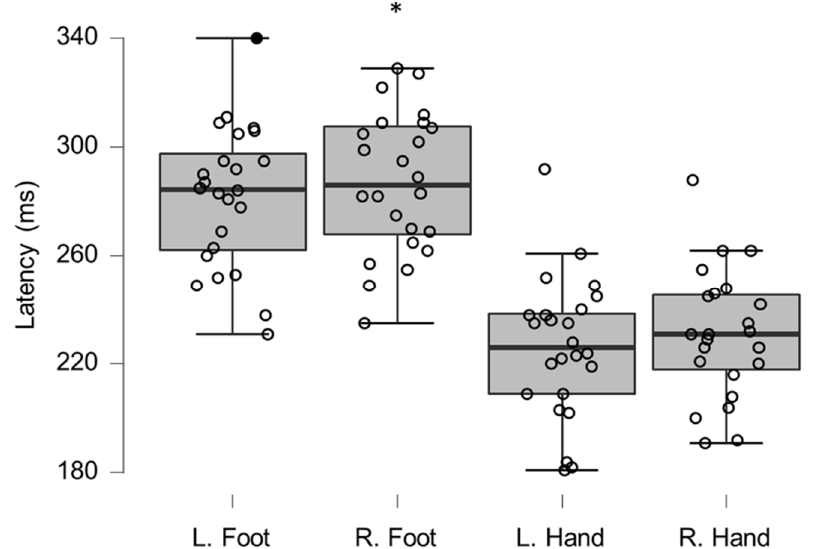
Figure 5. Box-plots for LEP latencies. Filled circles represent values ≥ two standard deviations out- side reference values. * indicates a statistically significantly lower median values compared to the reference material, with a Bonferroni-corrected p -value corresponding to